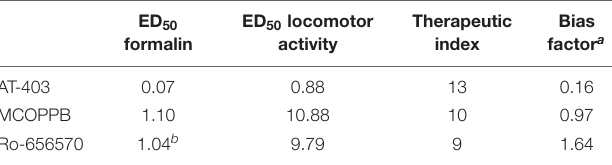
TABLE 1 | ED 50 , therapeutic index and bias factor for AT-403, MCOPPB, and